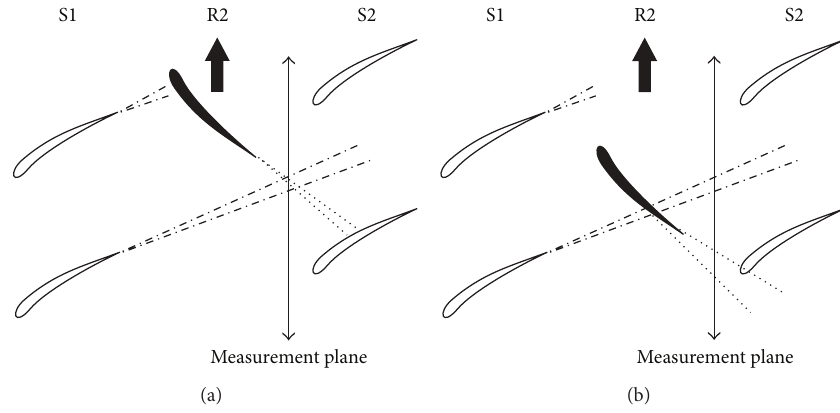
Figure 9: Cartoon describing Stator 1 wake and Rotor 2 interactions for CL6, in